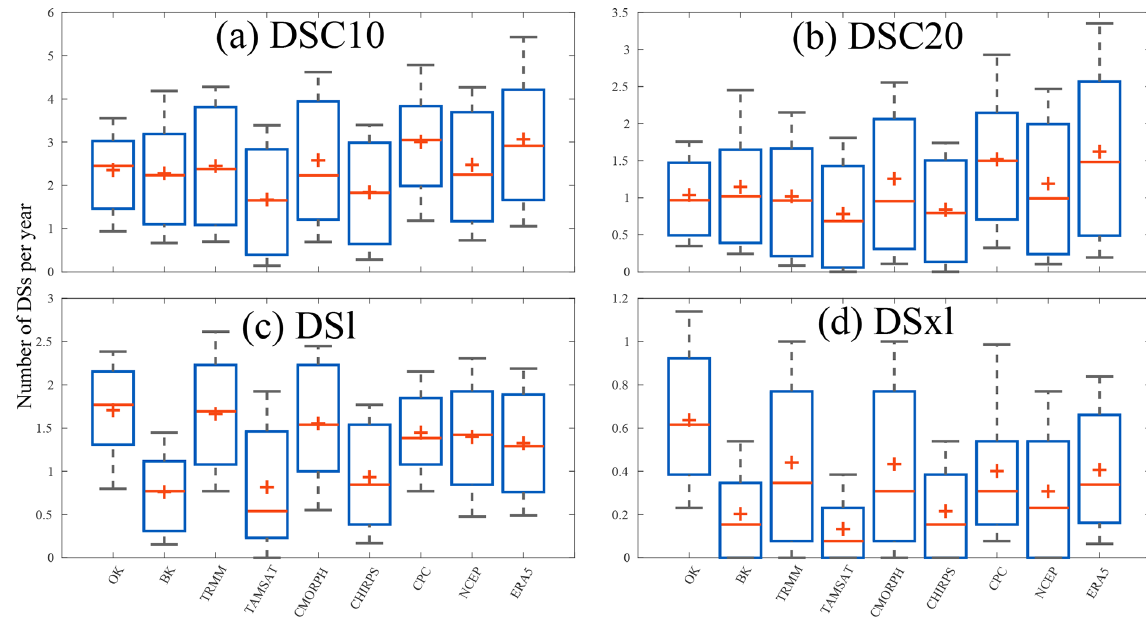
Figure 6. Box plots of average number of dry spells (DSC10, DSC20, DSl, and DSxl) per year collected for all grid points for the nine gridded datasets used (TRMM, TAMSAT, CMORPH, CHIRPS, CPC, NCEP, ERA5, BK, and OK). The minus sign ( − ) represents the median value, the plus sign ( + ) represents the mean value, the bottom and top edges of the box represent the 25th and 75th percentile values, respectively, and the whiskers represent the extreme values (5% and 95%). The average number of dry spells is computed for the overlap period (1998–2010). Details on the datasets and dry spells are provided in Tables 1 and 2,